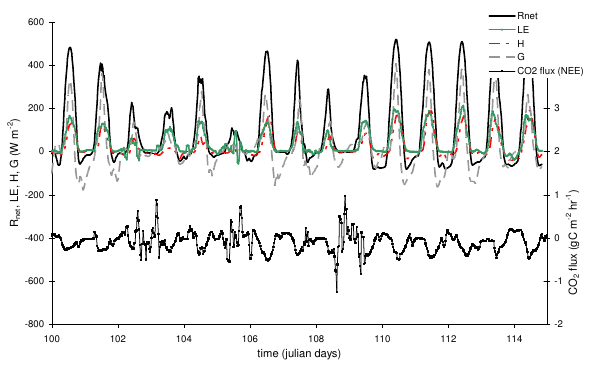
Fig. 3. Diurnal pattern of energy balance components net radiation, latent heat, sensible heat and ground heat flux and CO 2 flux for seven days in spring